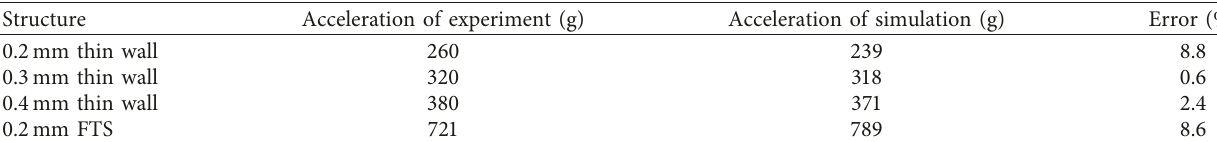
Table 5: Peak acceleration of experiment and